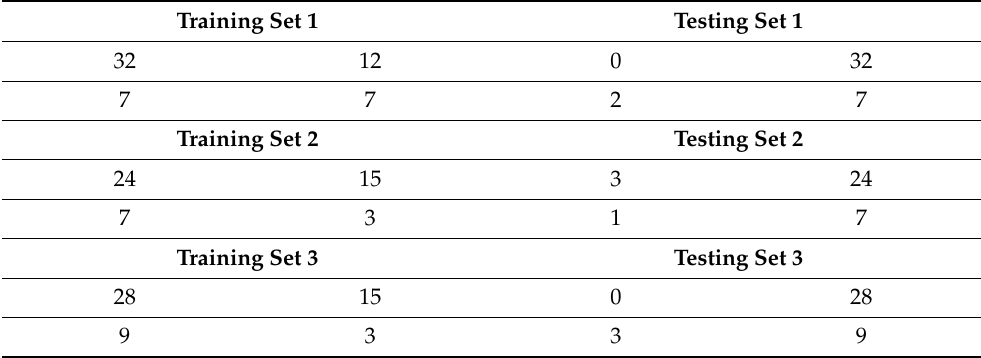
Table 6. Risk class prediction Confusion matrix of Training sets and Testing sets: in the upper left rectangle the true high risk is noted, in the upper right rectangle the false high risk is noted, in the lower left rectangle the false low risk is noted, in the lower right rectangle the true low risk is noted. Training Set